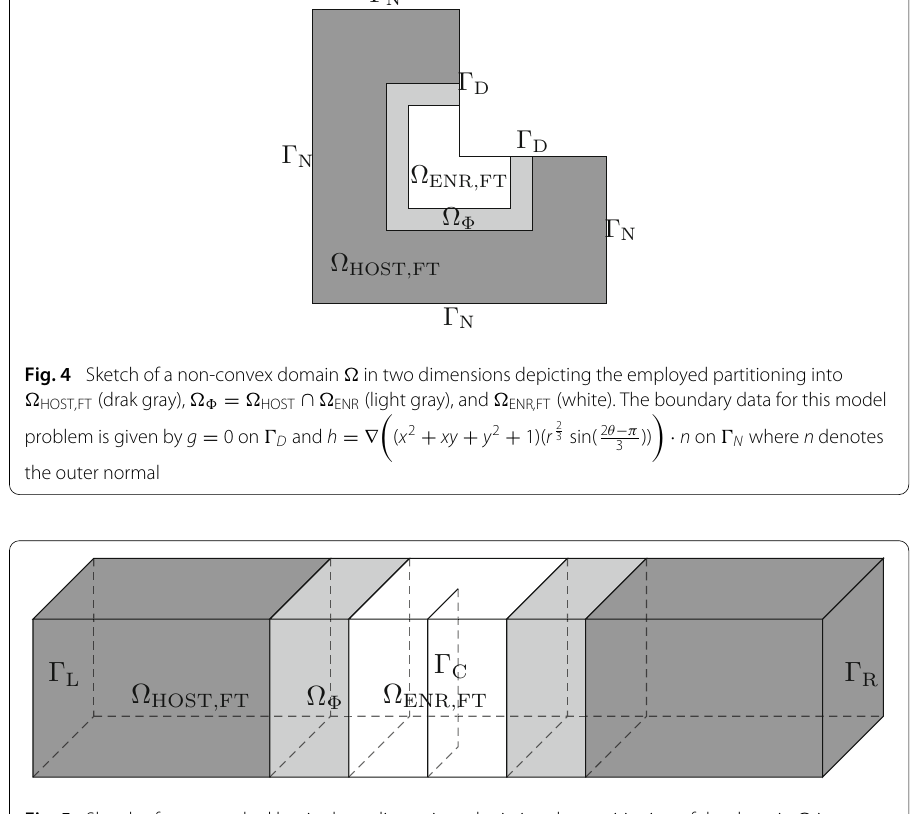
Fig. 5 Sketch of a pre-cracked bar in three dimensions depicting the partitioning of the domain (cid:5) into (cid:5) (cid:6) = (cid:5) ∩ (cid:5) (cid:5) (cid:5) HOST , FT (drak gray), HOST ENR (light gray), and ENR , FT (white). The boundary data for this model problem is given by (cid:7) D = (cid:7) L ∪ (cid:7) R , g = (0 , 0 , 0) T on (cid:7) L , g = (0 . 02 , 0 , 0) T on (cid:7) R and h = (0 , 0 , 0) T on = ∂(cid:5) \ (cid:7) (cid:7) N